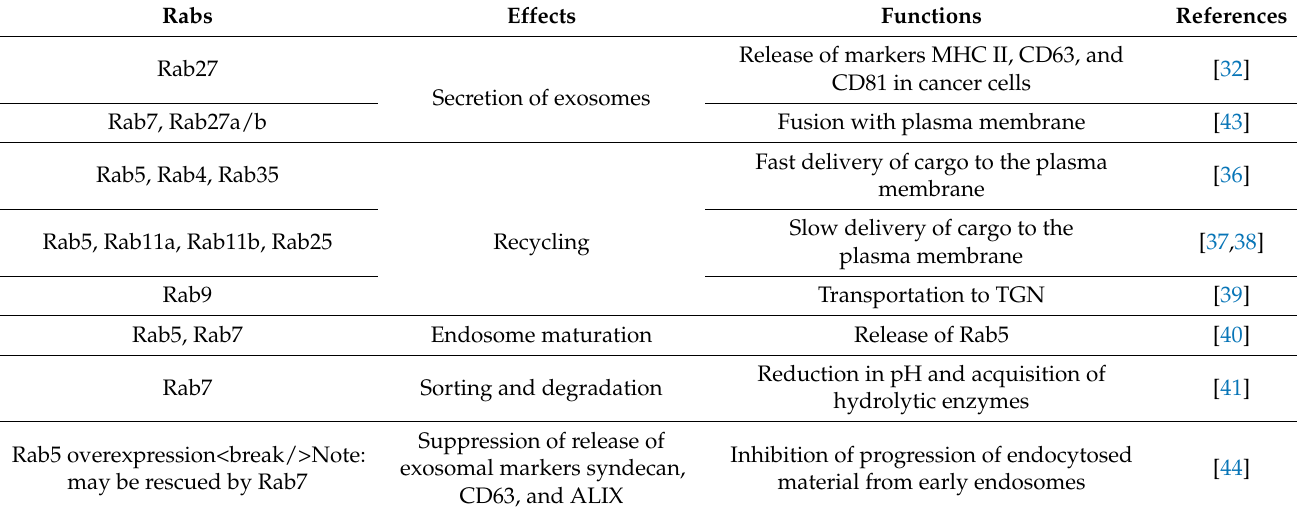
Table 1. Different types of Rabs and their function in endocytic